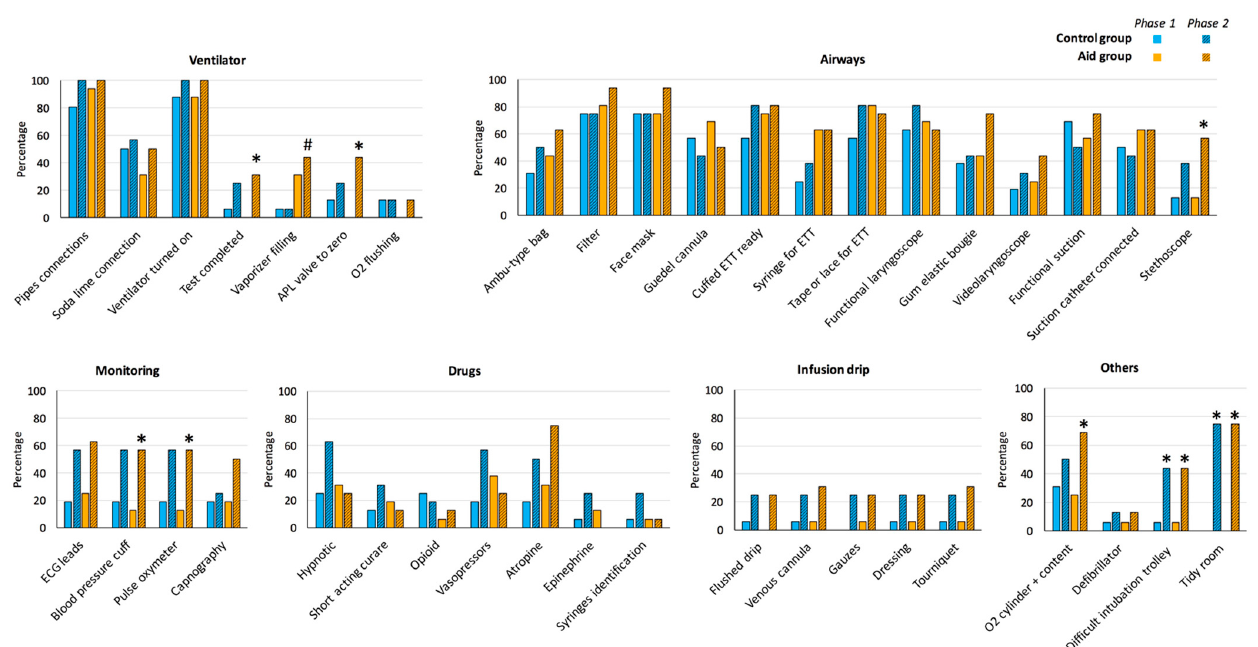
Figure 2. Percentages of residents who validated each required item in the first 5 min in control (blue bars) and aid (yellow bars) groups in phase 1 (plain filling) and phase 2 (hatched filling). *, p < 0.05 using a paired comparison with phase 1. p < 0.05 between the control group and the aid group in phase 2. p < 0.05 between the control group and the aid group in phase